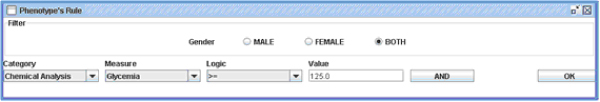
Phenotype generation panel. The Phenoype Editor panel for phenotype generation. Menus are automatically generated from the variables stored in the database. The rule that defines the phenotype is composed combining multiple conditions with the logical AND operator. A similar panel is also available to combine phenotypes together using the logical OR operator.